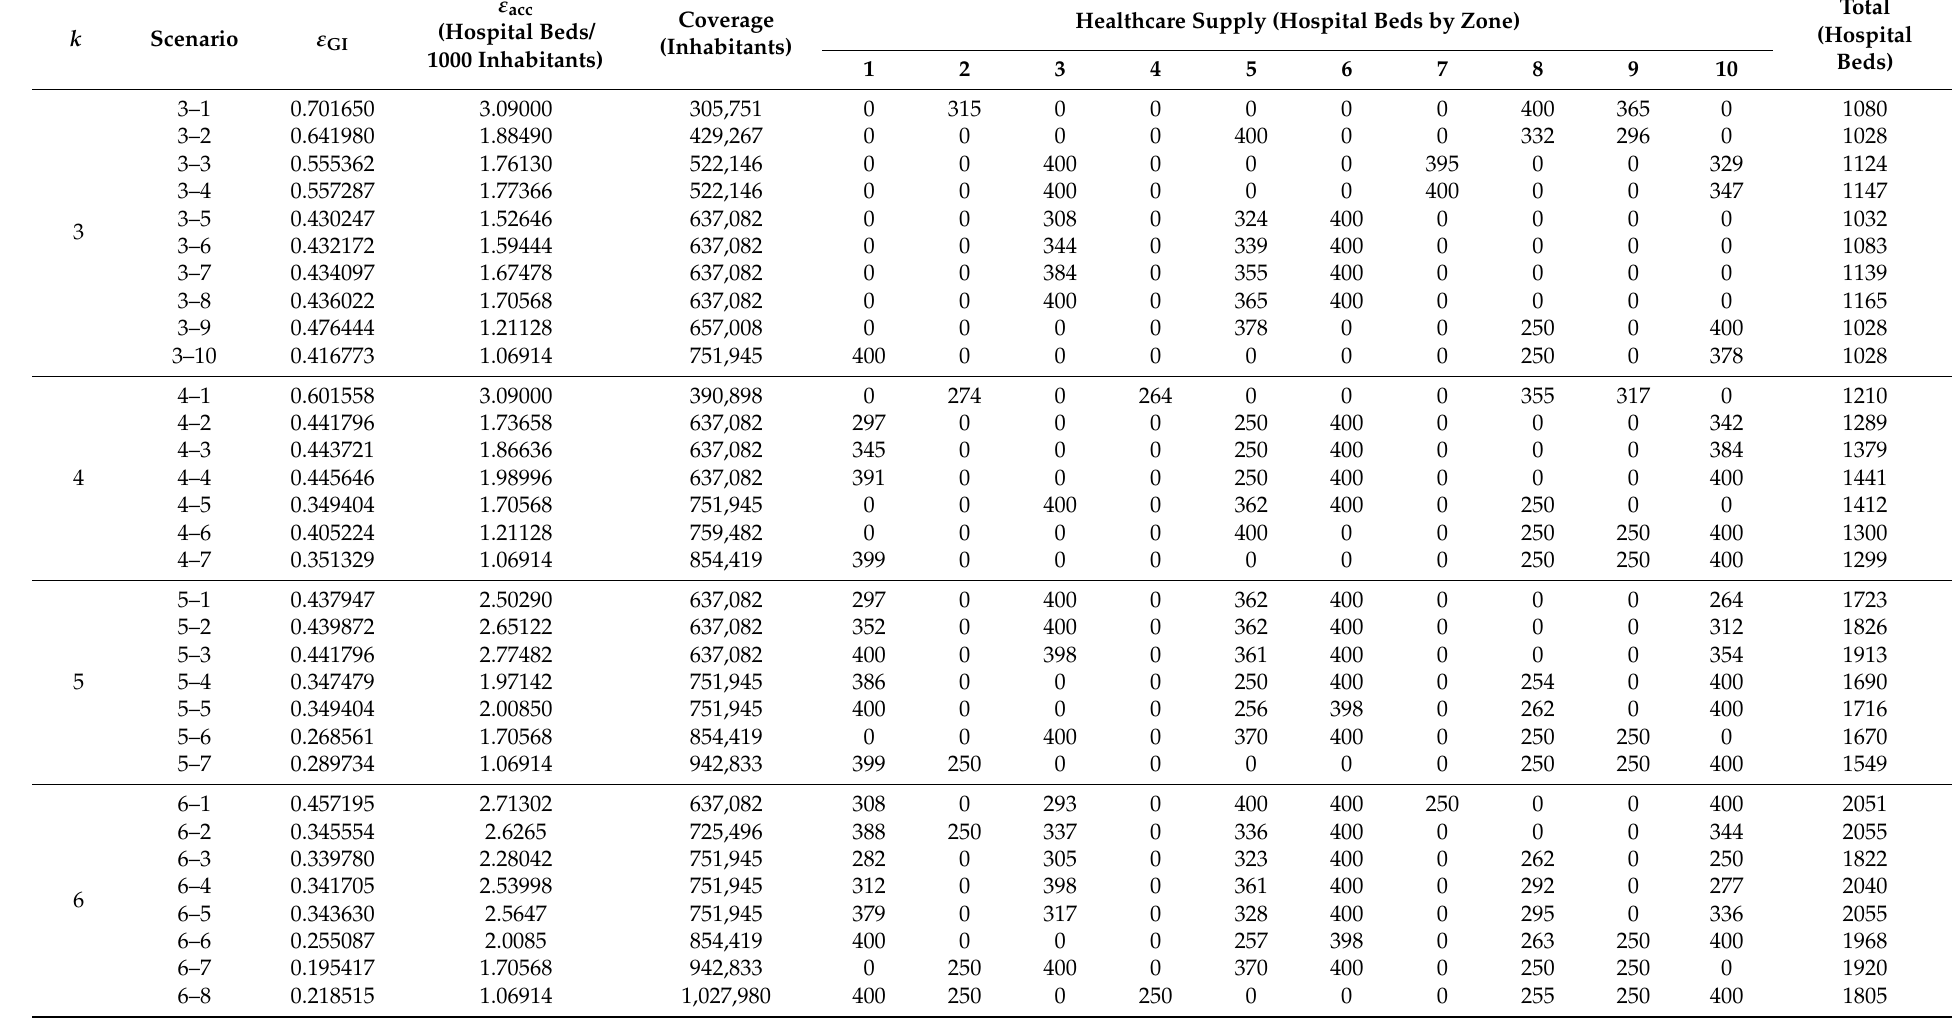
Table 4. Pareto frontier set for the listed k , scenario, zone, and other indicators in instance